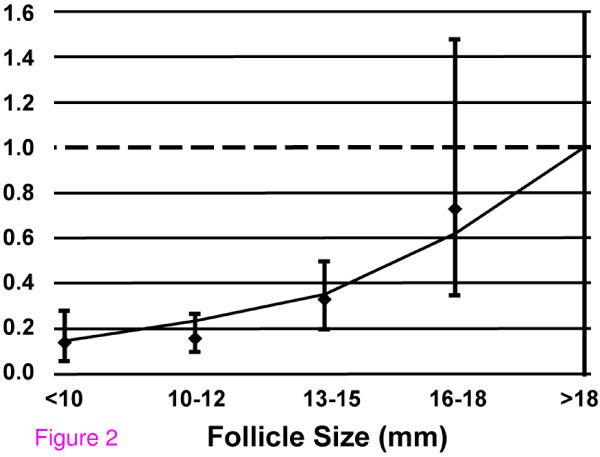
Odds of oocyte recovery varies with follicle size. Adjusted odds of oocyte recovery for each follicle size compared to lead follicular group (>18 mm). The relationship of oocyte recovery and follicle size is a monotonic trend (AOR = 0.63, P < 0.001)